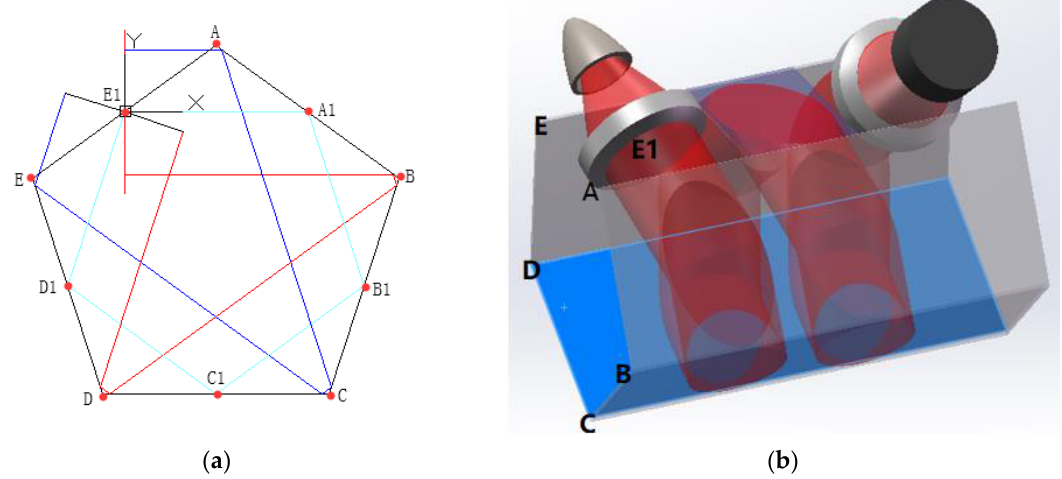
Figure 3. ( a ) Mathematical model of cross-section and ( b ) three-dimensional spiral structure of the pentahedron gas-cell.